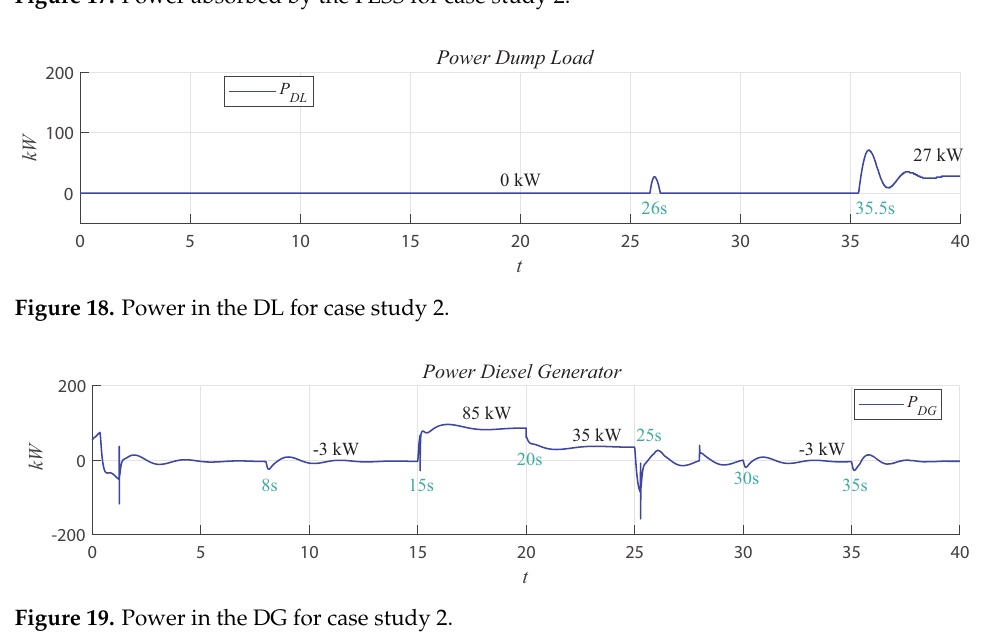
Figure 17. Power absorbed by the FESS for case study 2.